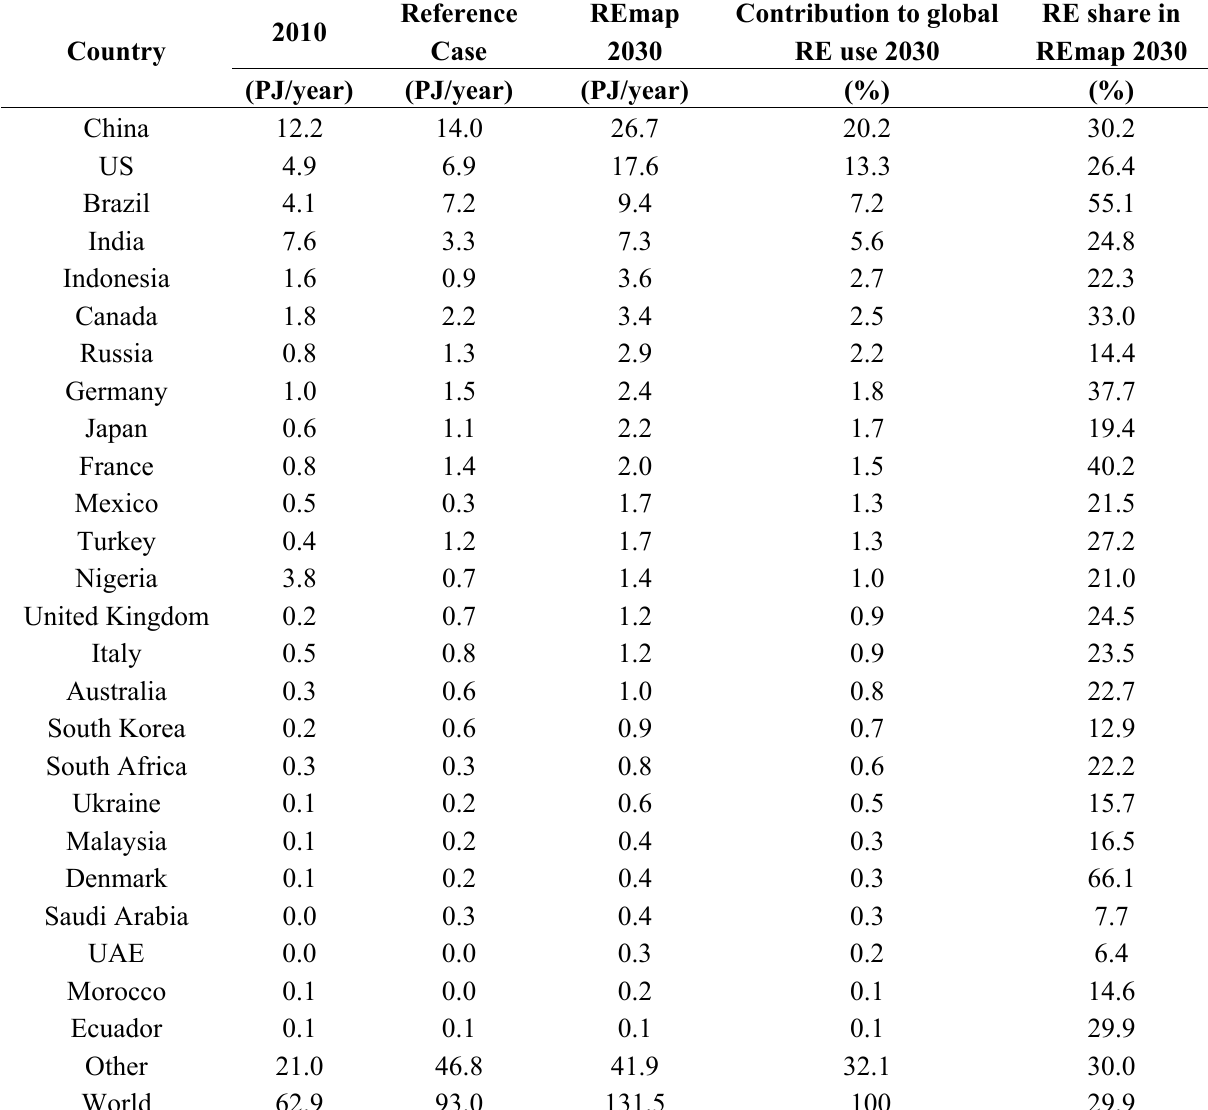
Table 1. RE use by country in 2010, for the Reference Case and REmap in 2030, and their corresponding contributions to the global RE use and shares in